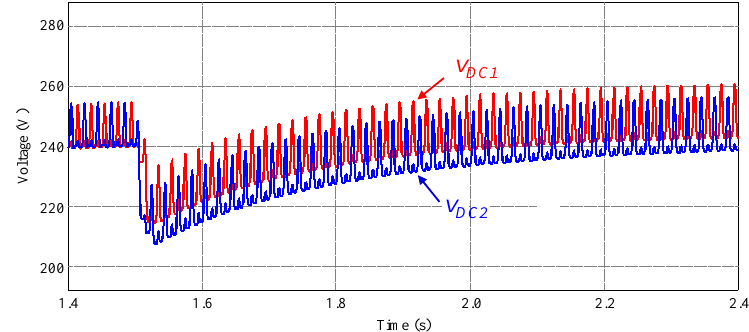
Figure 14. Transient analysis of the SAPF operation with the connection of a non-linear load: ( a ) Load ( i L ) and source ( i S ) currents; ( b ) SAPF reference ( i F *) and actual ( i F ) compensation current.